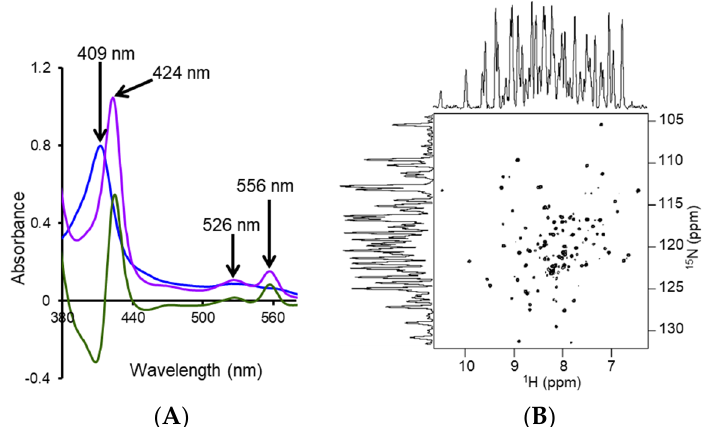
Figure 9. ( A ) Absorbance spectra of recombinant ~16-kDa rabbit cytochrome-b5 isolated in native E. coli native lipid-nanodiscs using an anionic SMA-EA polymer: oxidized form (409 nm) (blue), sodium dithionite-reduced form (424, 526 and 556 nm) (magenta), and difference spectra (reduced minus oxidized) (green). ( B ) 2D 1 H/ 15 N TROSY-HSQC NMR spectrum of 15 N-labelled cytochrome- b5 in E. coli native lipid polymer-nanodiscs. This Figure and caption are adopted from reference